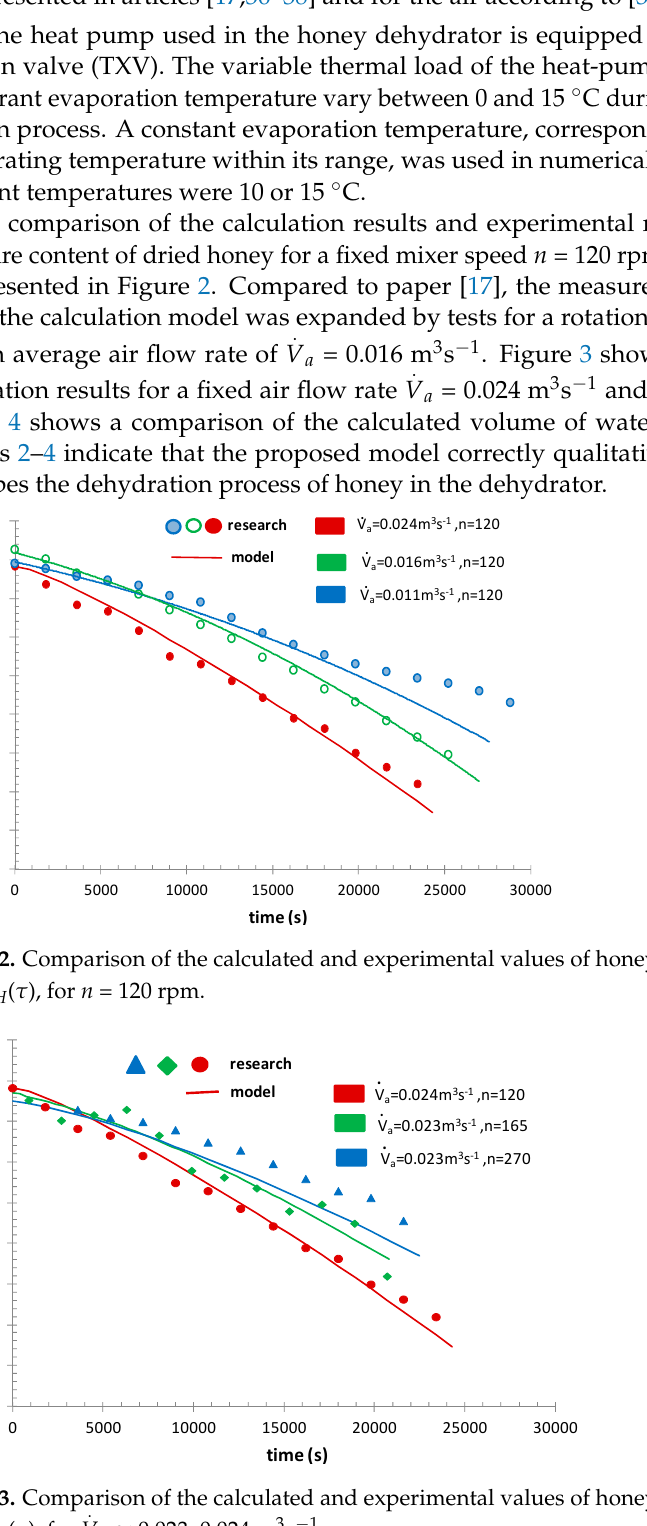
Figure 4. Comparison of the calculated and experimental values of the amount of water removed from honey as a function of time m w ( τ ), for 𝑉(cid:4662) (cid:3028) ≈ 0.023–0.024 m 3 s − 1 . As result of a 2.24-fold increase in air flow rate, the final moisture content of honey is reduced by 3% and the drying time is reduced by 1.3–1.6, depending on the evaporation temperature. Table 2 summarises the agreement between the calculation and measurement results of honey moisture content. The average relative error of honey moisture determination for all cases is low and does not exceed 2%. For the lowest airflow rate, the maximum error in calculating the instantaneous moisture value of honey relative to the measured results was 7.7%. This discrepancy may be due to the low experimental and calculated values of heat and mass transfer coefficients, whose values may be subject to the largest measurement error [17]. Table 2. Accuracy of honey moisture determination for the adopted dehydrator calculation model Calc. Variant